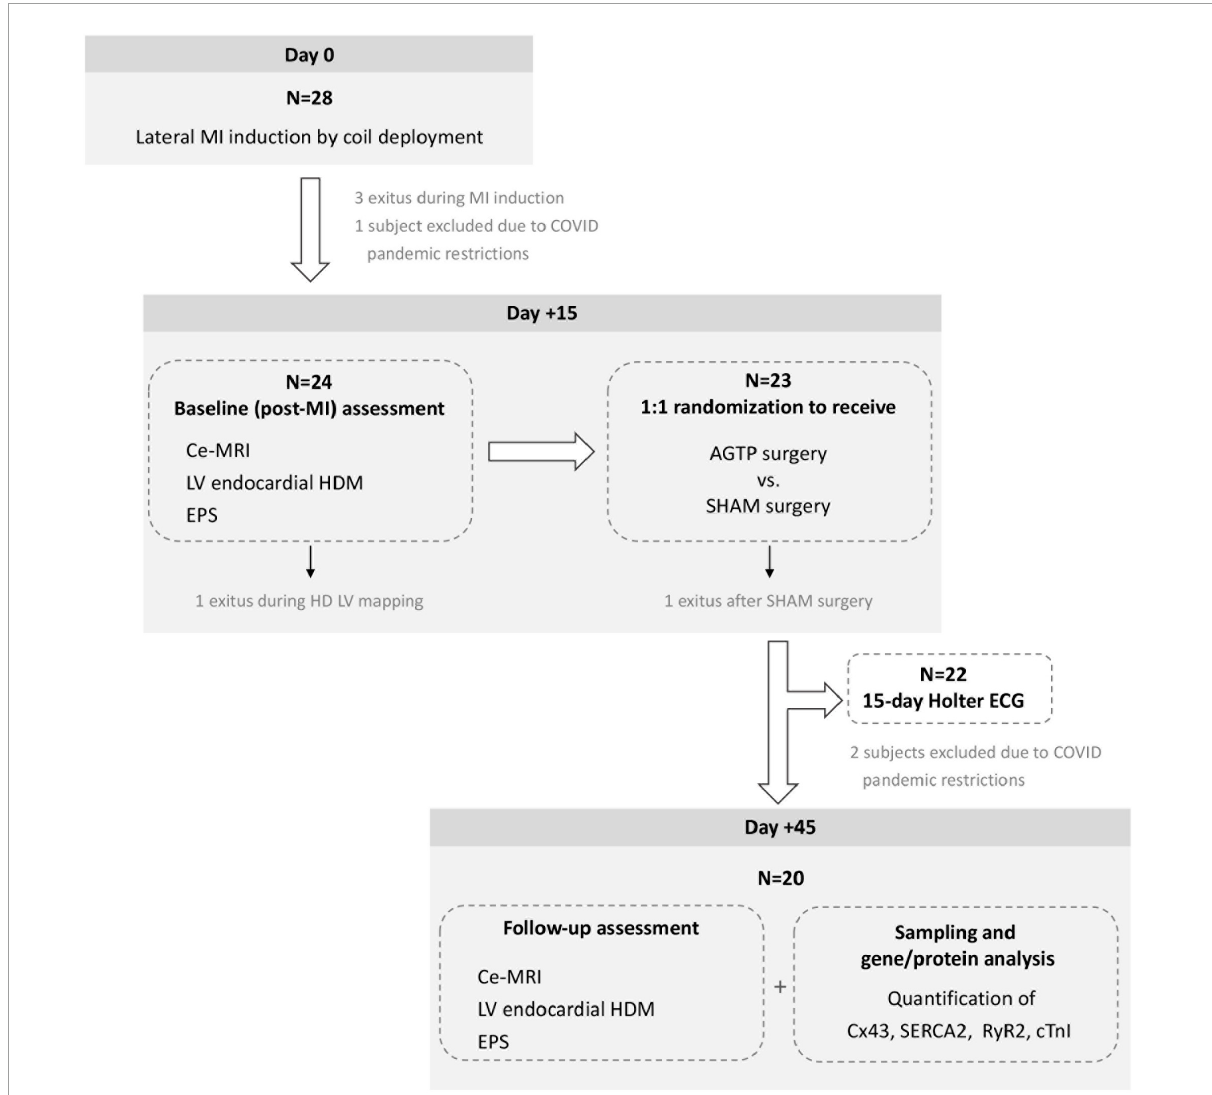
FIGURE1 Chronogram and workflow of the study. ce-MRI, contrast-enhanced magnetic resonance imaging; HD, high density; LV, left ventricular; EPS, electrophysiological study.